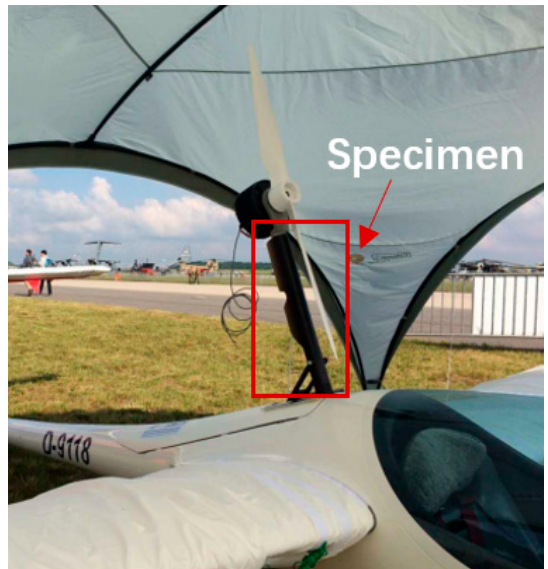
Figure 11. The retractable structure of a sailplane.